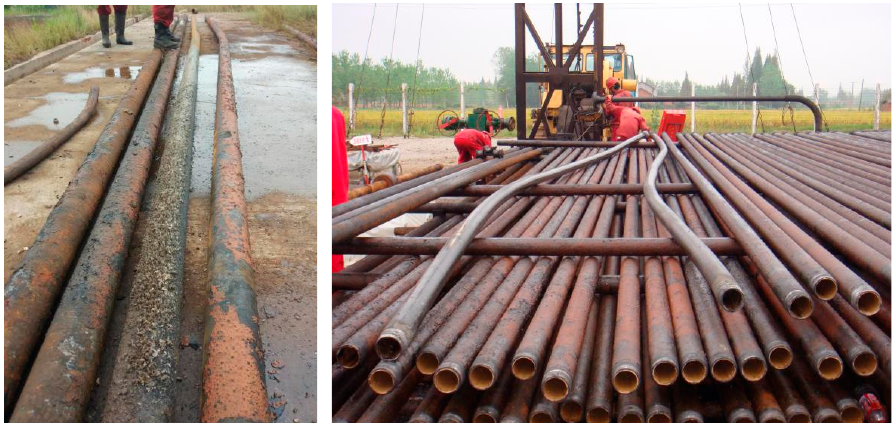
Figure 2. Bending deformation diagram of leaching strings of SCGSs.